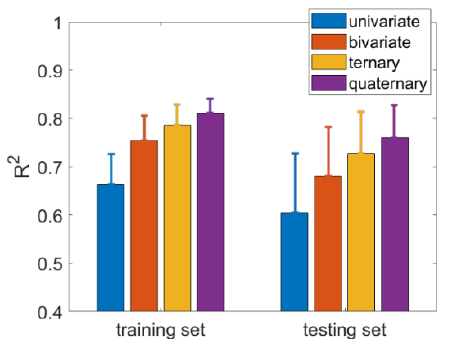
Figure 3. Average of R 2 for the combinations containing different variables. Table 5. The best model of different parameter combinations.